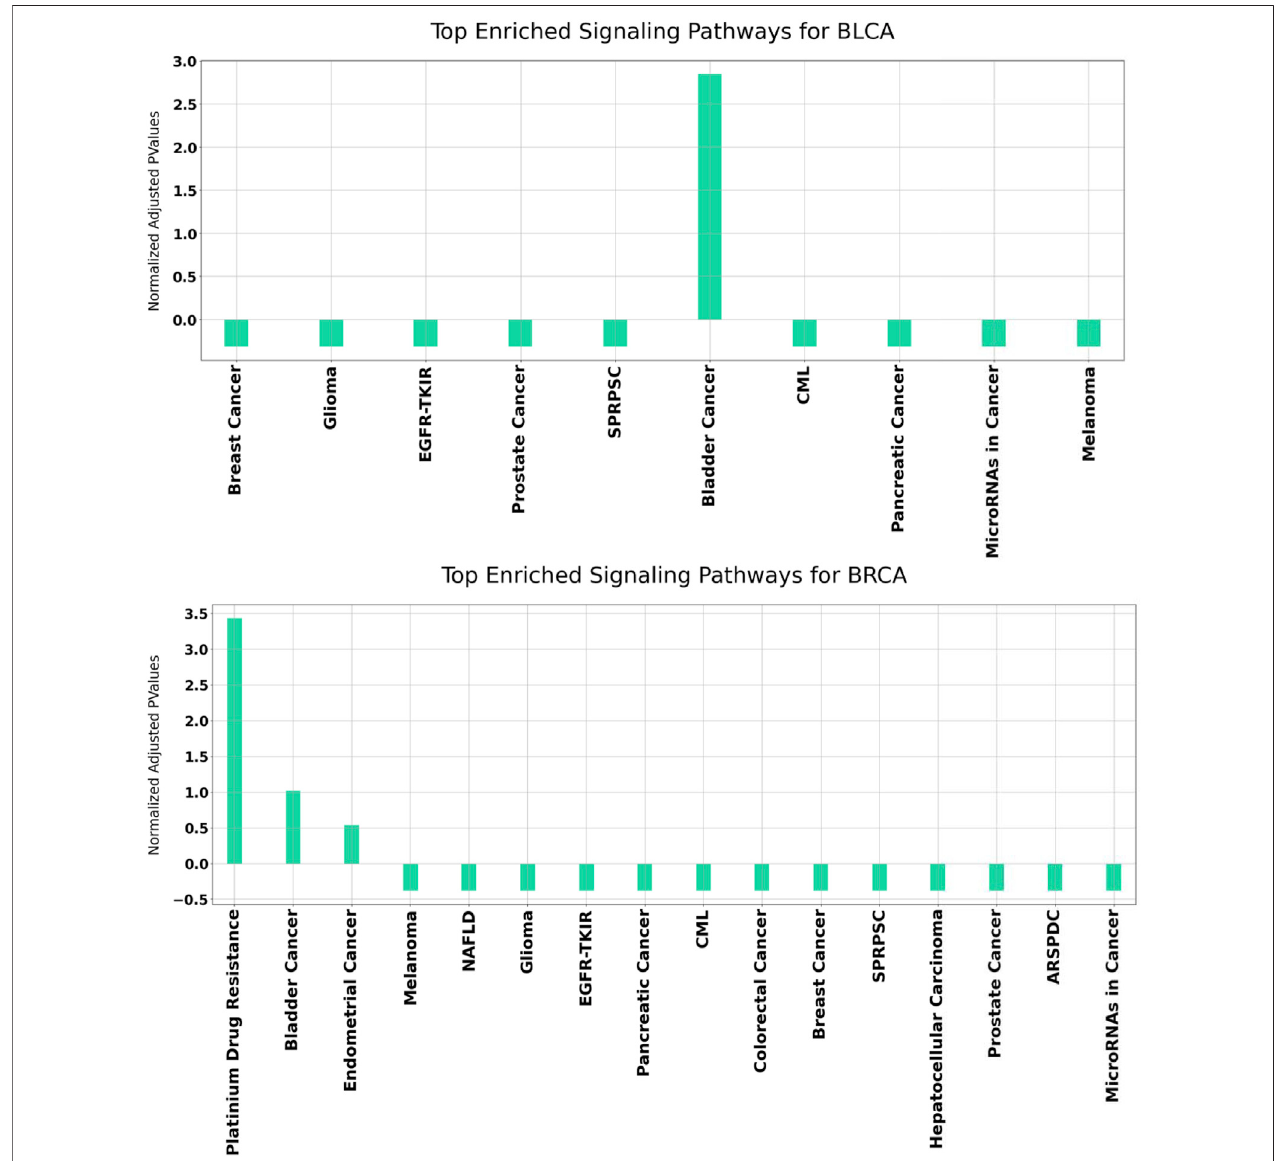
FIGURE7| FunctionalenrichmentresultsforBLCAandBRCAusingGeneCodis.The p ValuesoftheenrichedKEGGpathwaysrefertothenormalizedvaluesusing meannormalization.SPRPSCstandsforSignalingPathwaysRegulatingPluripotencyofStemCells,EGFR-TKIRstandsforEGFRTyrosineKineaseInhibitorResistance, CML stands for Chronic Myleoid Leukemia, NAFLD stands for Non-Alcoholic fatty Liver Disease, ARSPDC stands for AGE-RAGE Signaling Pathway in Diabetic Complications.